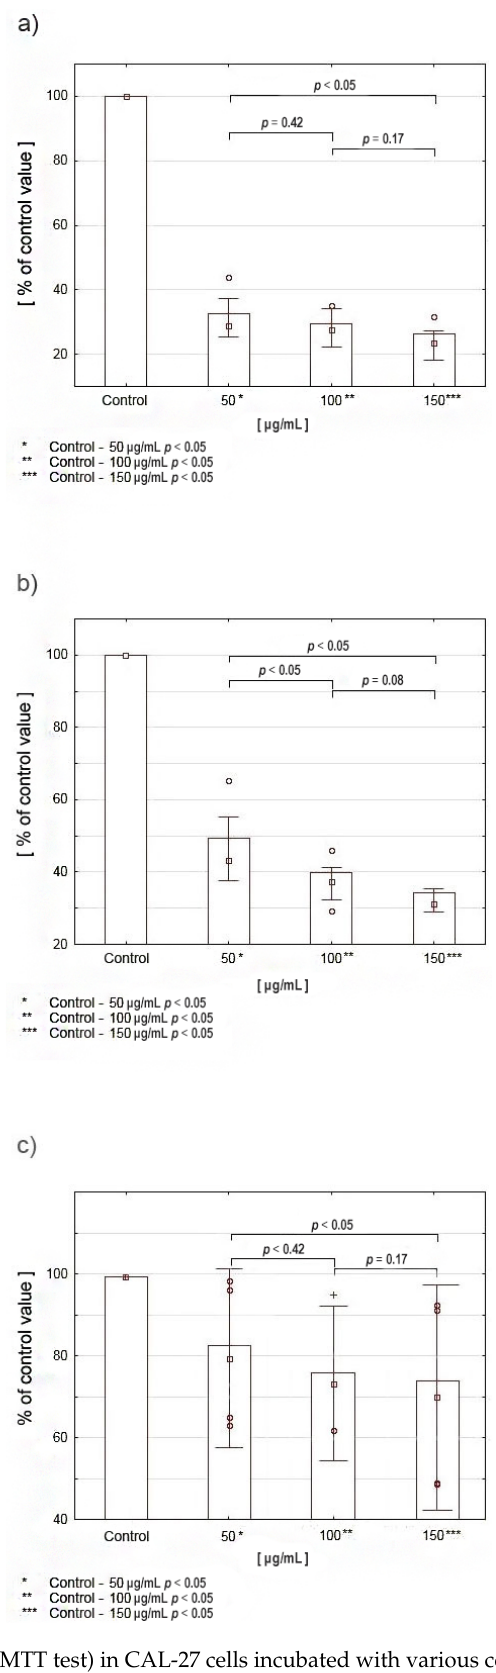
Figure 4. Viability assay (MTT test) in CAL-27 cells incubated with various concentrations of celecoxib: ( a ) after 24 h, ( b ) after 48 h, ( c ) after 72 h.